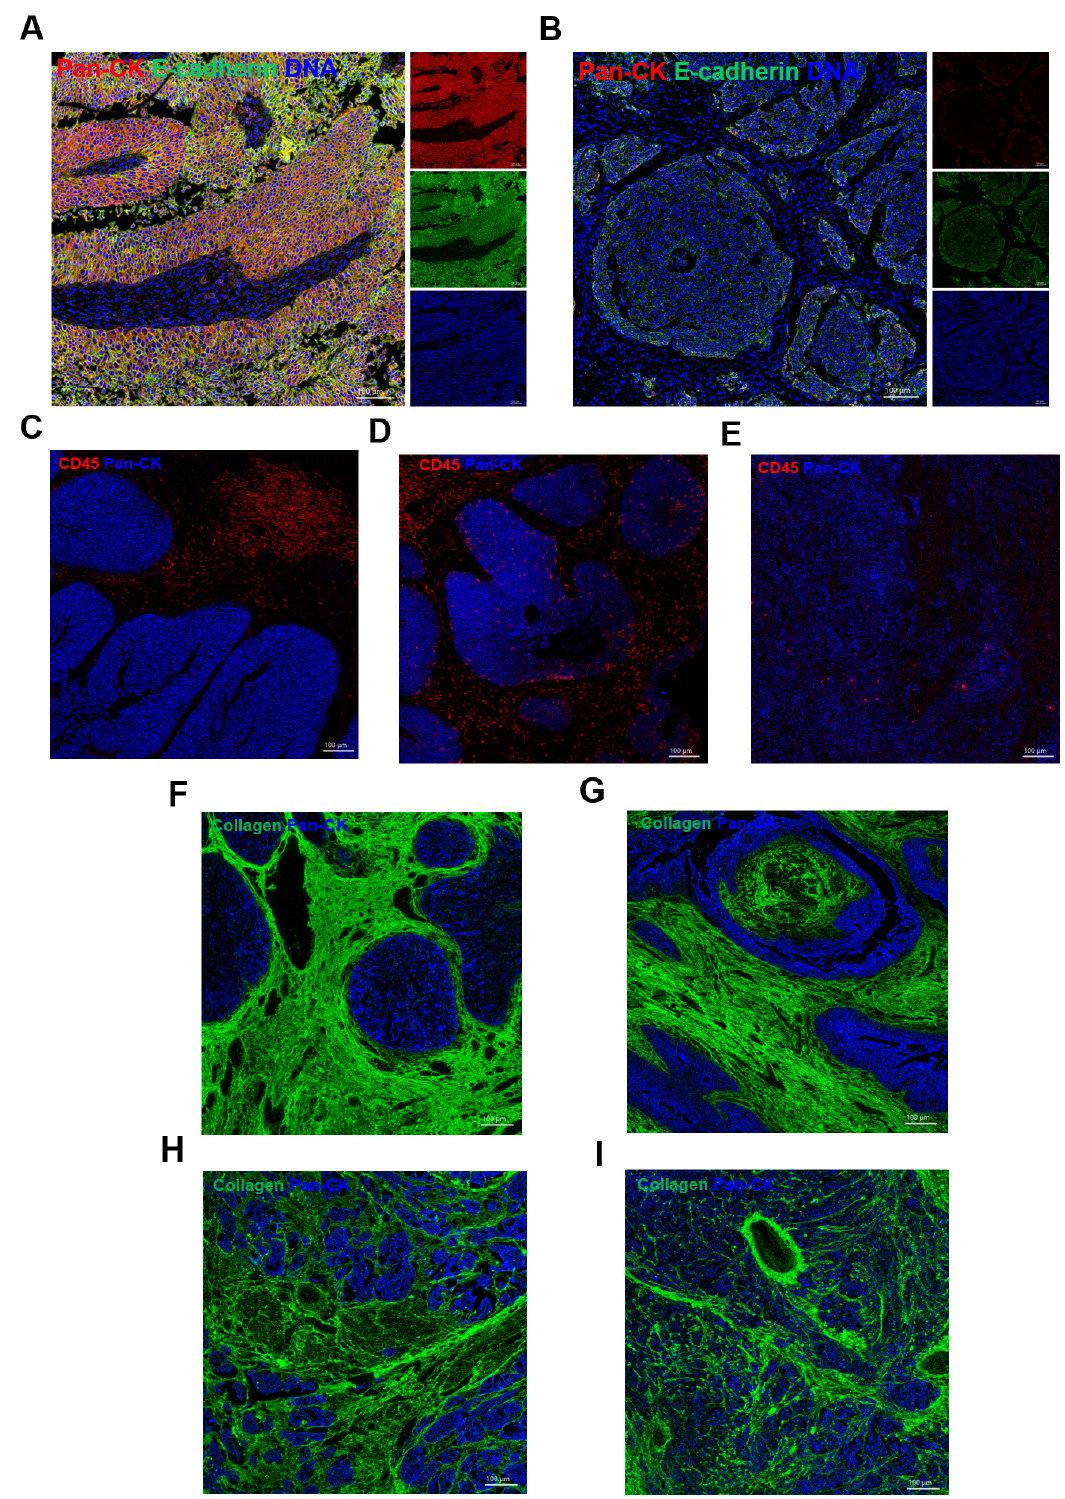
Figure 6. The spatial resolution-based phenotypes of the MIBC TME. ( A , B ) Images of differentiated tumor cells ( A ) and dedifferentiated tumor cells ( B ), Pan-CK presents as red, E-cadherin presents as green, DNA presents as blue. ( C – E ) Three spatial distribution patterns of immune cells, type I ( C ), type II ( D ), type III ( E ), CD45 presents as red, Pan-CK presents as blue. ( F – I ) Four spatial distribution patterns of collagen signatures, type I ( F ), type II ( G ), type III ( H ), type IV ( I ), Collagen presents as green, Pan-CK presents as blue.